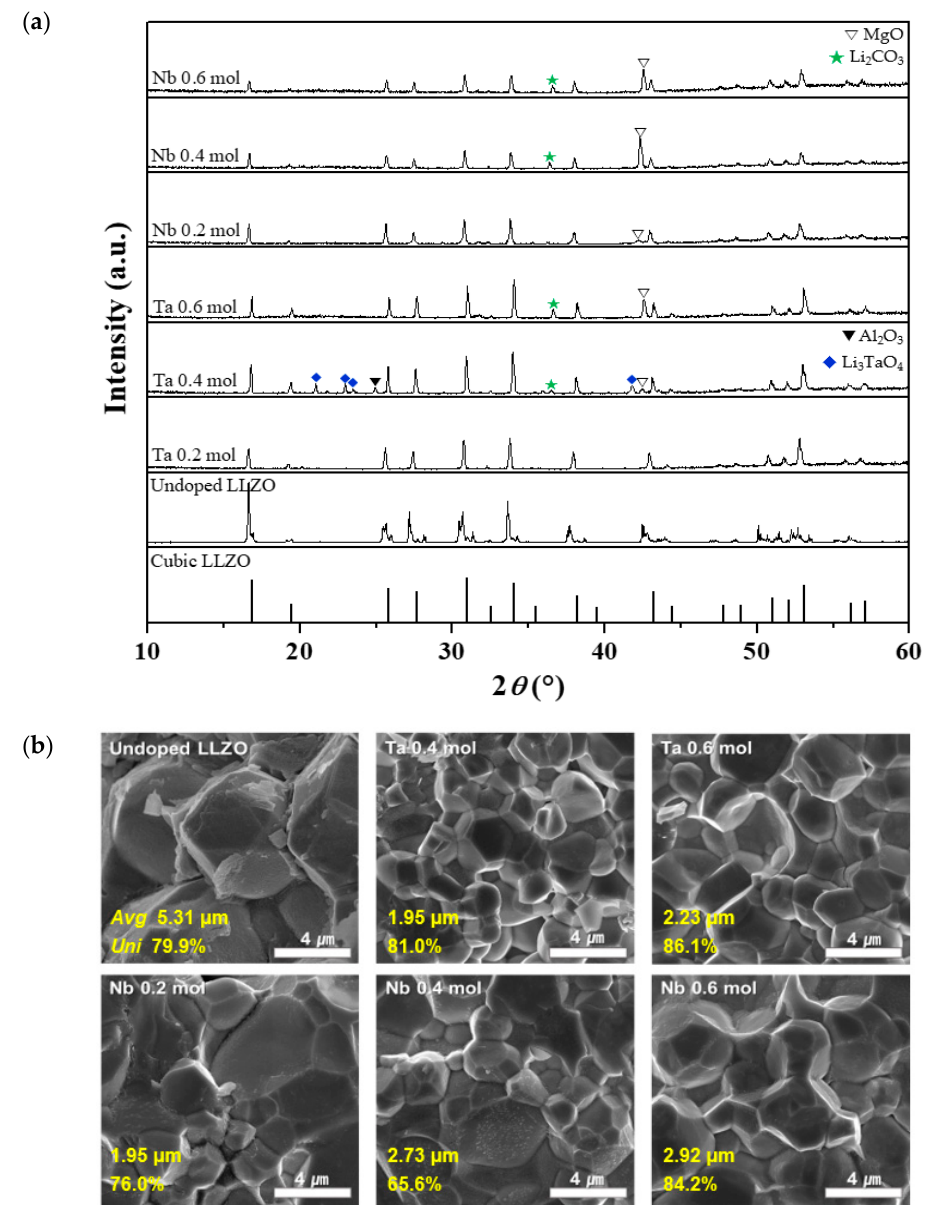
Figure 2. Crystal structure and morphology of M-doped LLZO ceramics (mono-doping of the Zr 4+ site with 0.2–0.6 mol Ta or Nb): ( a ) X-ray diffraction (XRD) patterns and ( b ) field-emission scanning electron microscopy (FE-SEM) images of the fracture surfaces ( Avg and Uni : the average and the uniformity of grain size,